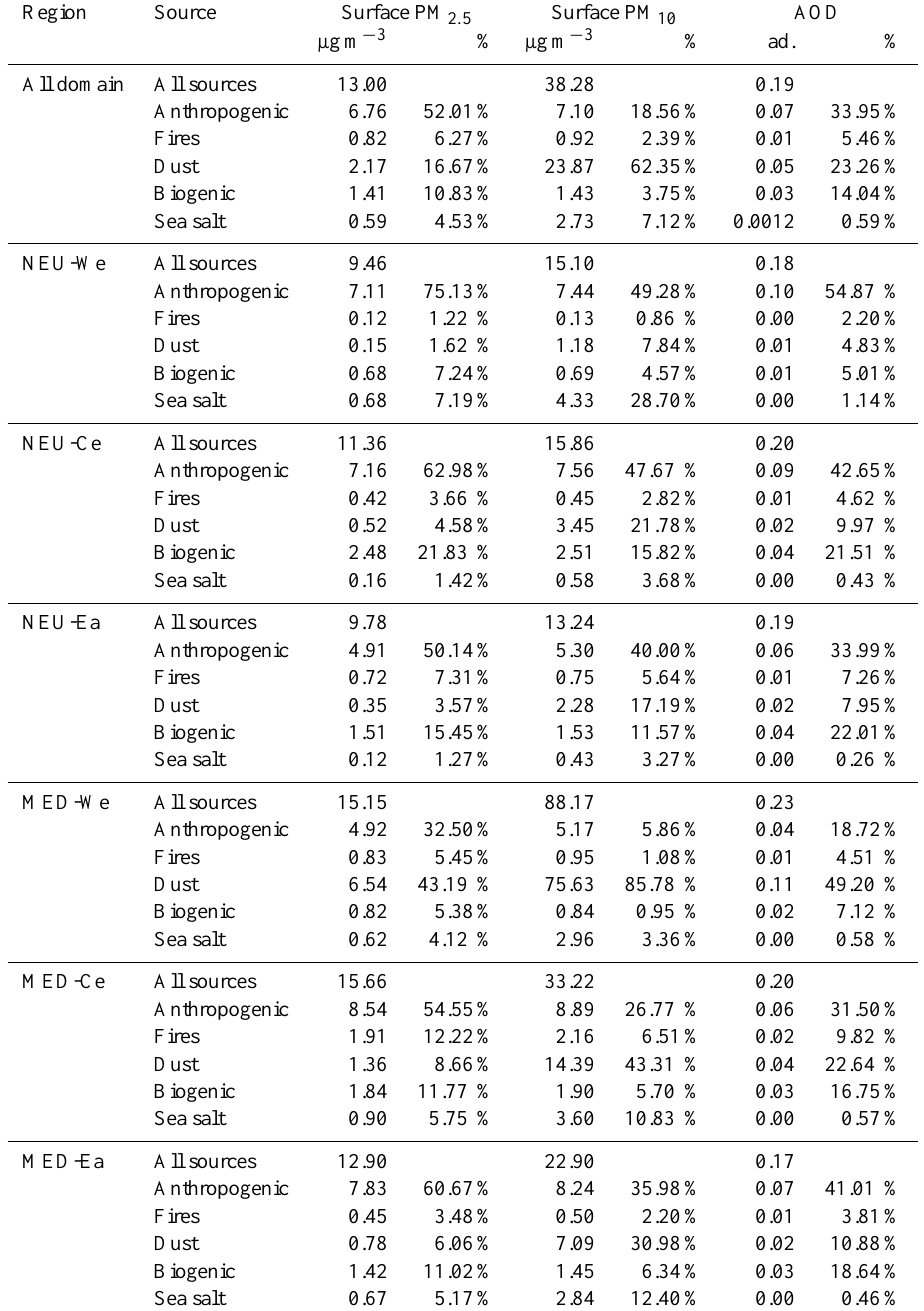
Table 5. Contributions of each emission source type to surface PM 2 . 5 and PM 10 concentrations and AOD for the full domain and the different sub-regions indicated in Table 1 over the period (1 June to 31 August